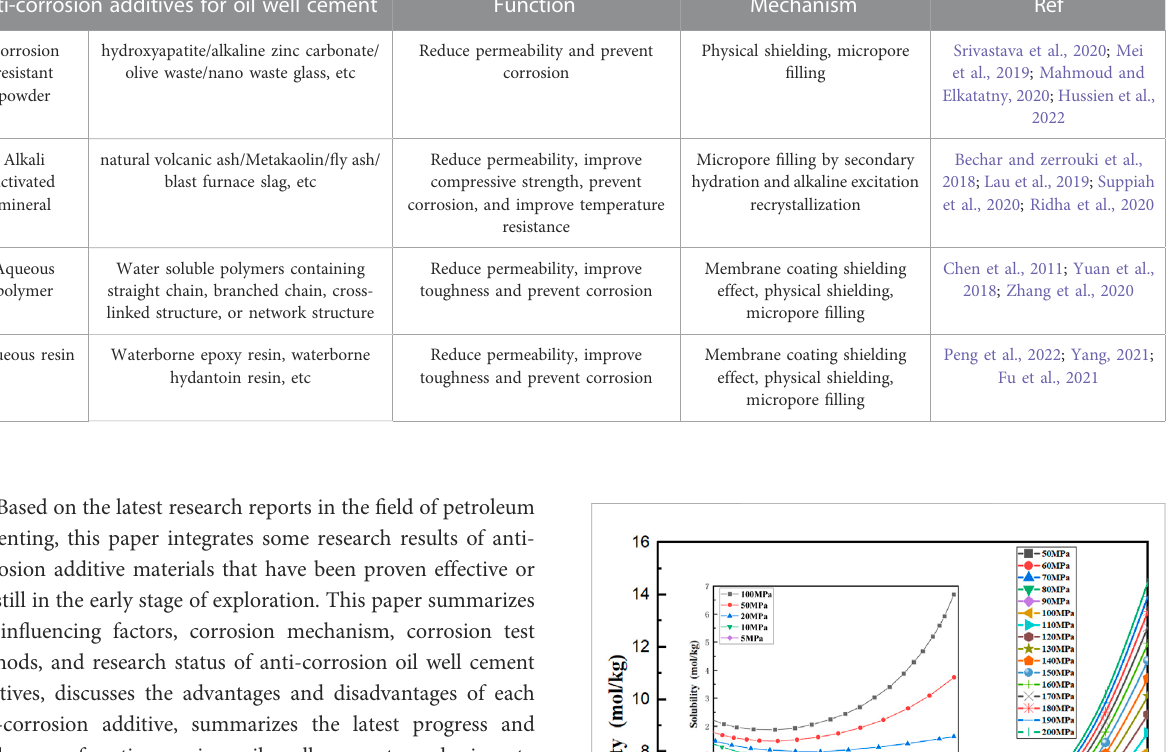
TABLE 1 The latest types of common anti-corrosion additives for oil well cement. Anti-corrosion additives for oil well